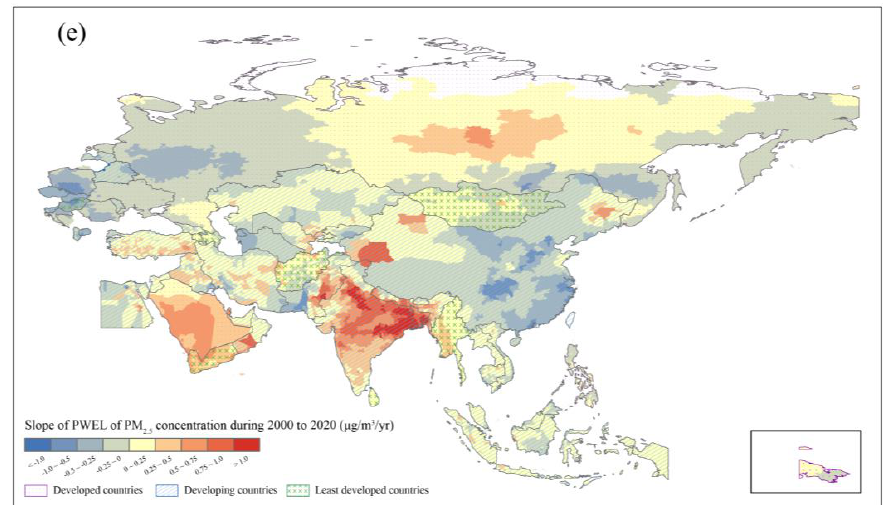
Figure 7. ( a ) the distribution of slope of PWEL of PM 2.5 concentration for the whole B&R region, the distribution of slope of PWEL of PM 2.5 concentration for ( b ) developed countries, ( c ) developing countries, ( d ) least developed countries, ( e ) the spatial distribution of slope of PWEL of PM 2.5 concentration in B&R region from 2000 to